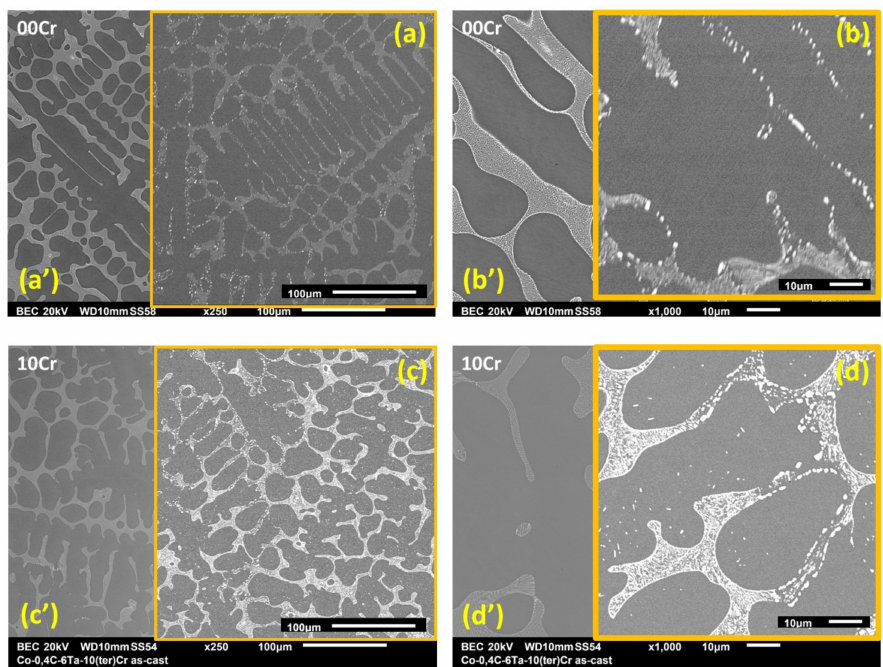
Figure 7. The (1400 K; 96 h)-aged microstructures (framed in orange) of the 00Cr ( a , b ) and 10Cr ( c , d ) alloys; general ( × 250: ( a , c )) and detailed ( × 1000: ( b , d )) views; addition of the as-cast microstruc- tures (00Cr: ( a ’, b ’), 10Cr: ( c ’, d ’)) for comparison.